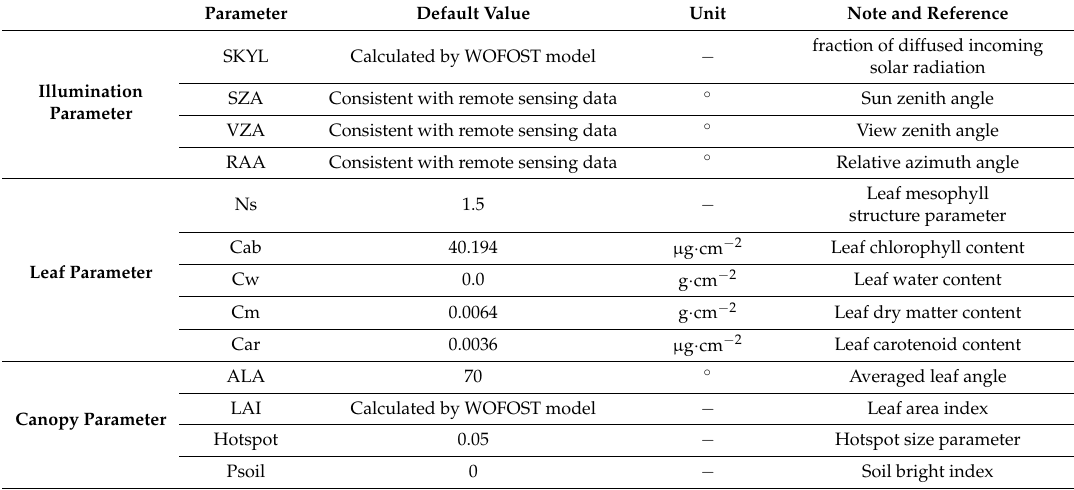
Table 3. The parameters used in the PROSAIL model for simulated seasonal FAPAR of